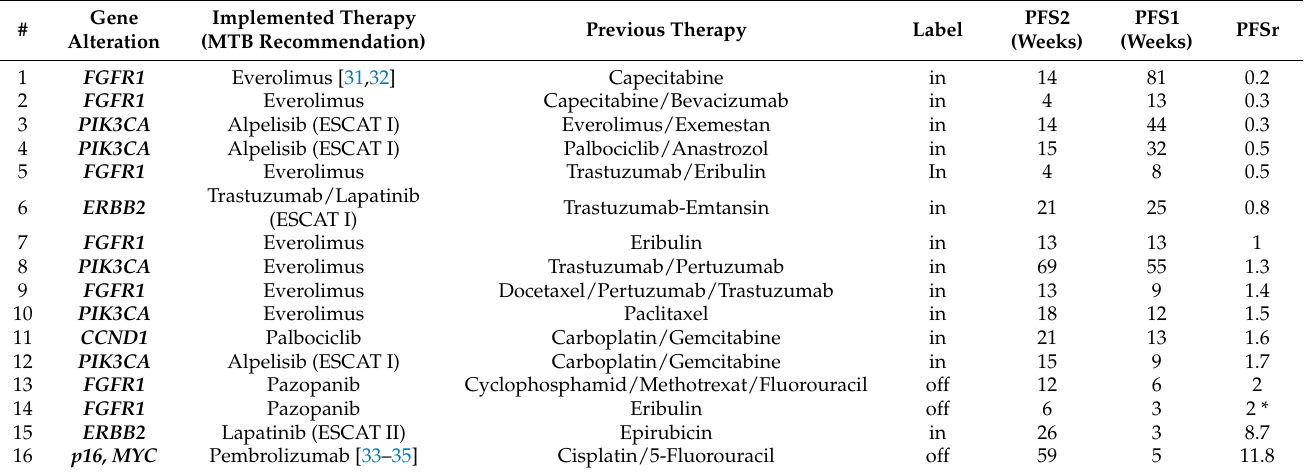
Table 4. Patients with implemented treatment recommendations (in- and off-label).